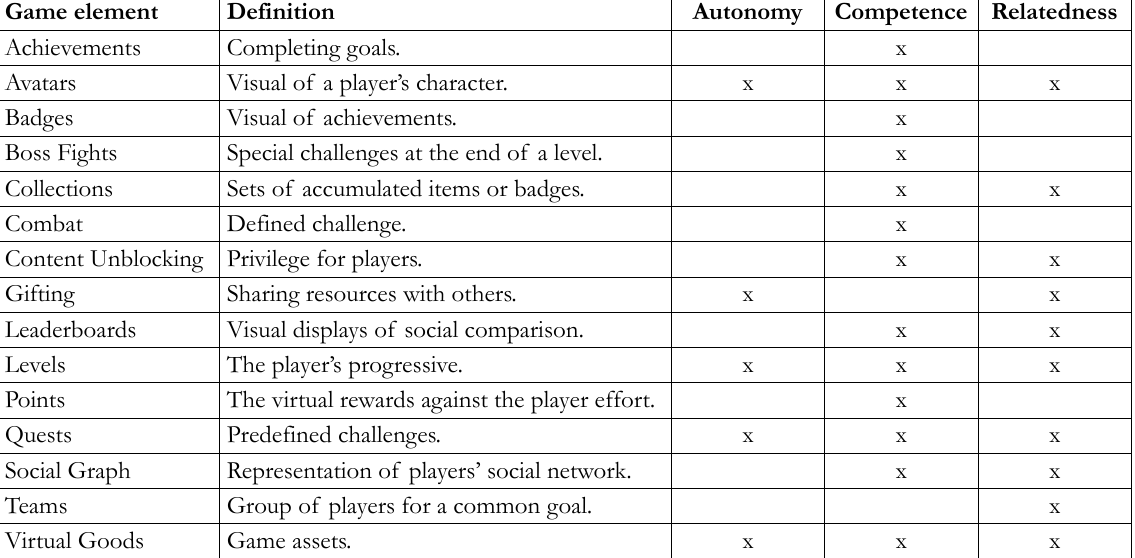
Table 1. The relationship between game elements (Components) and Self-Determination Theory (Werbach & Hunter,